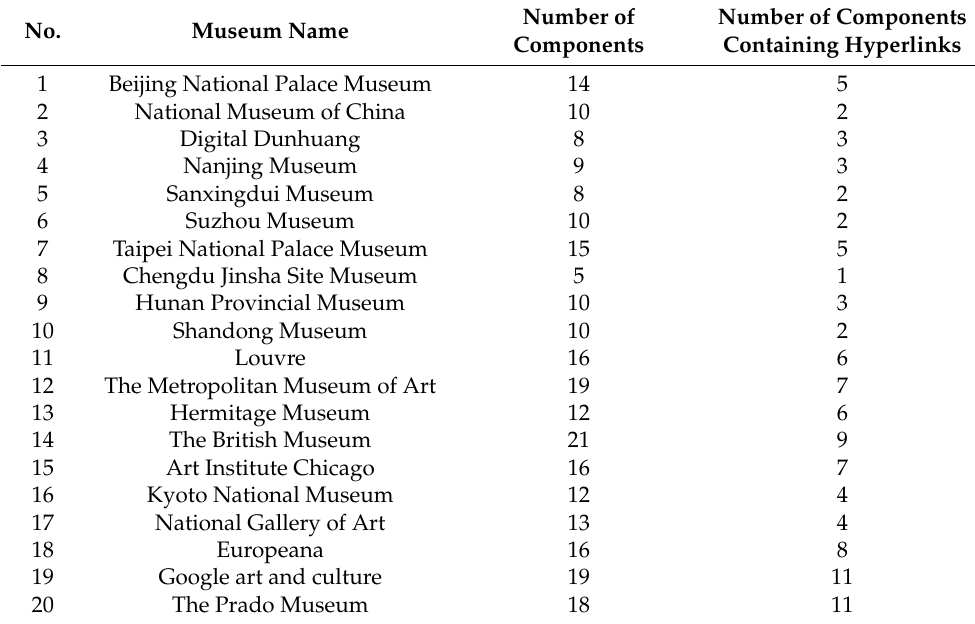
Table 1. Target museums and the number of their